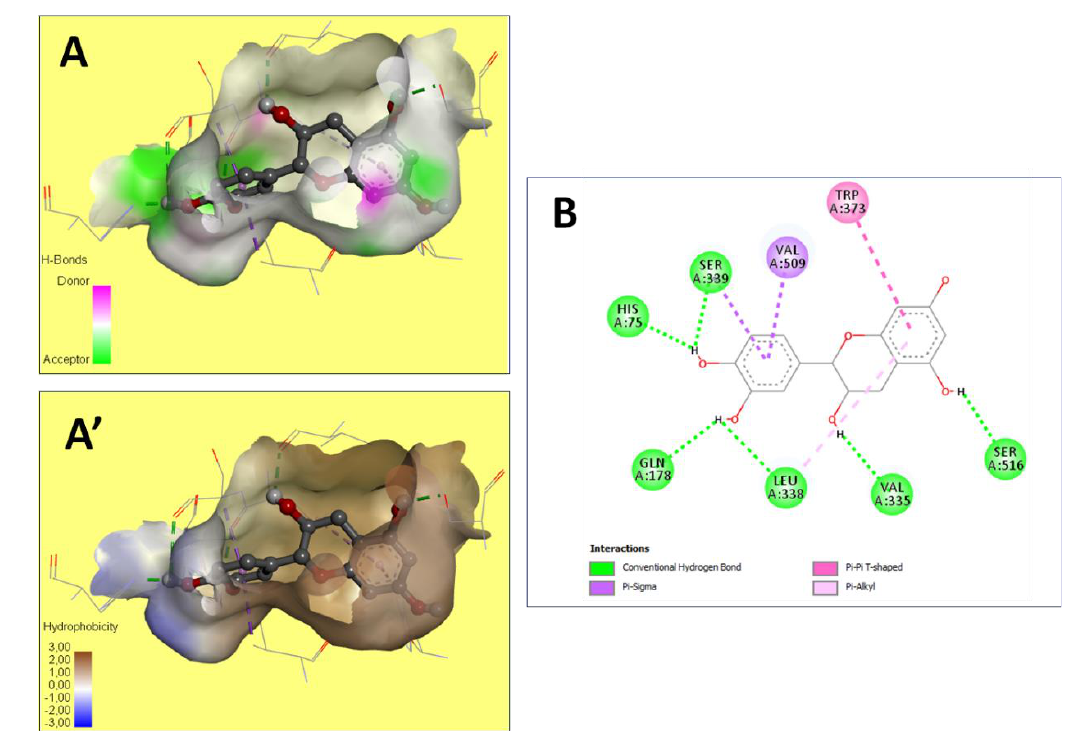
Figure 5. The representation of the 3D structure of «Catechin» with the best docking scores, bounded to the pocket region of COX-2. Micrographs of the pocket region with hydrogen bond ( A ) and hy- drophobicity illustrations ( A ′ ) and the corresponding 2D diagram of interactions ( B ).